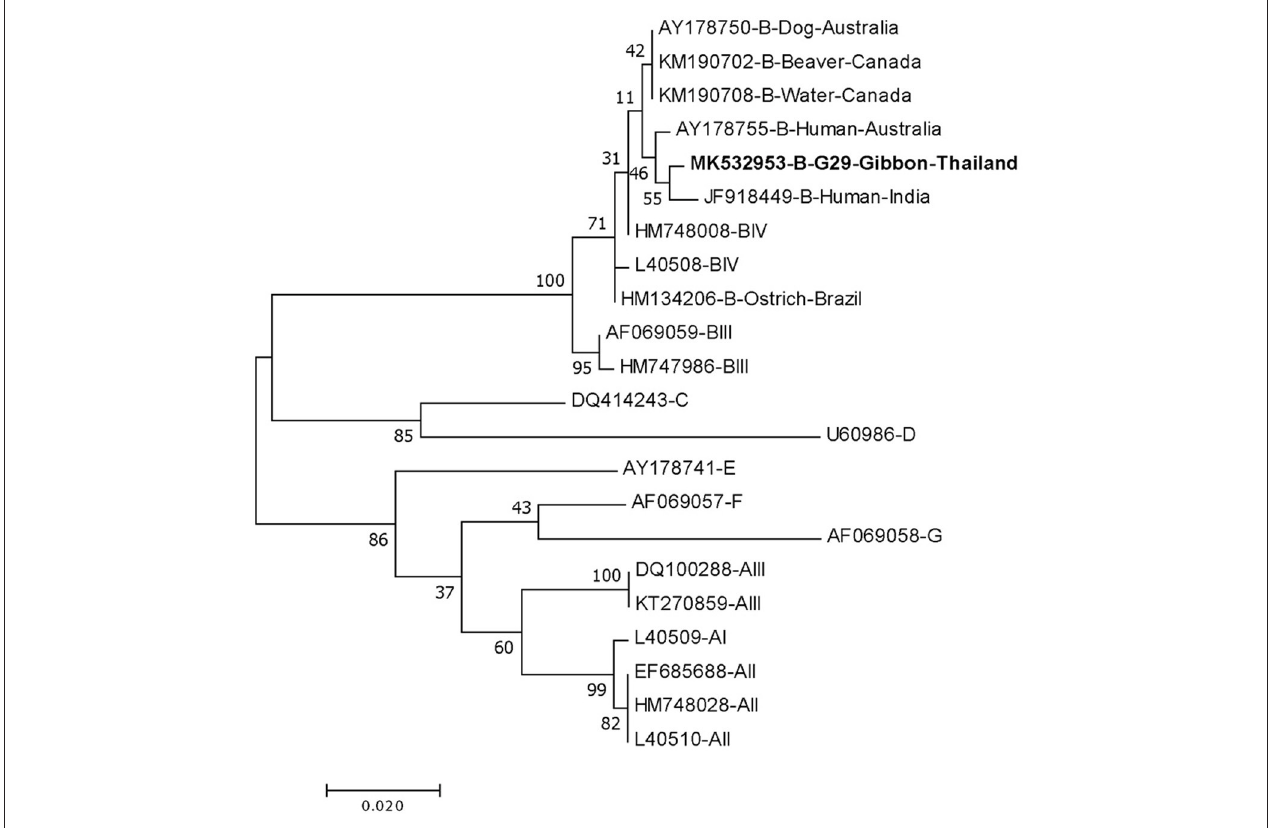
FIGURE 2 | Phylogenetic tree of Giardia isolate based on the sequence of glutamate dehydrogenase (gdh) gene from a gibbon in this study by the Maximum Likelihood algorithm using the MEGA 6.06 program. Sequences obtained from GenBank are indicated by their accession numbers. Percentage bootstrap supports (500 replicates) are shown by numbers at the respective nodes. Bold texts represent the Giardia detected in this